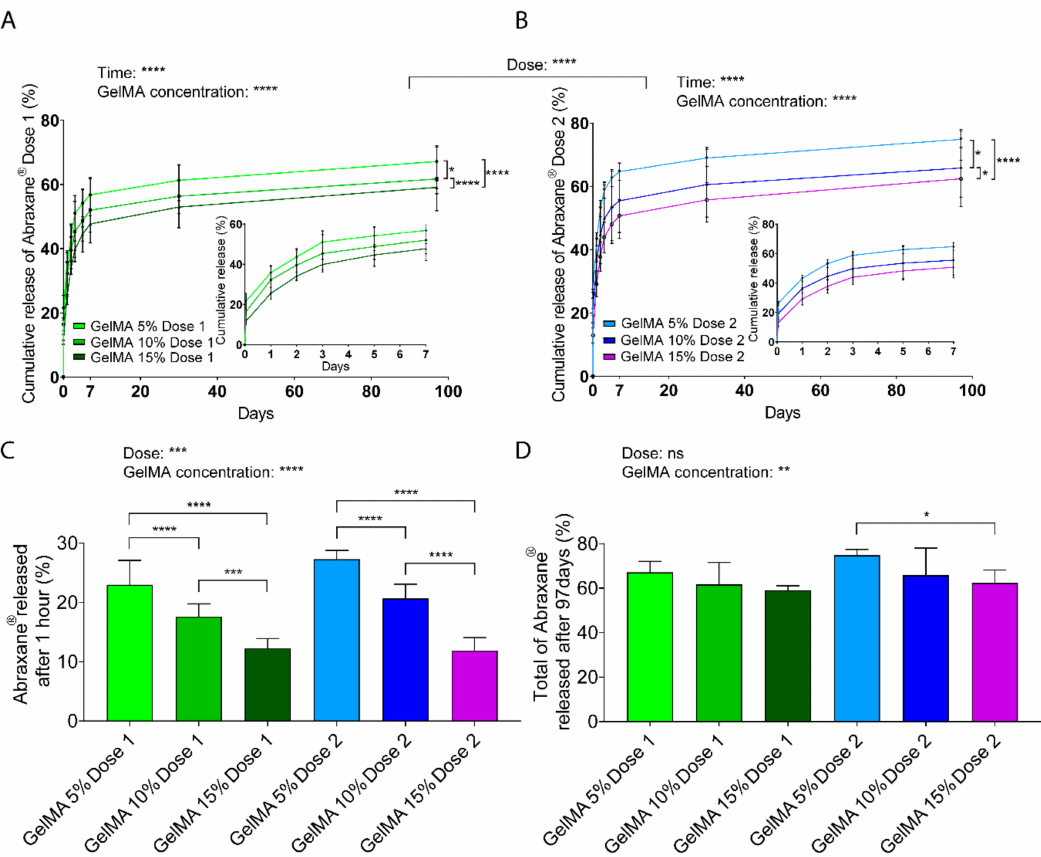
Figure 3. Release kinetics of FITC-labeled Abraxane ® from GelMA hydrogels, as measured in phosphate-bu ff ered saline pH 7.4, under gentle agitation at 37 ◦ C. ( A – B ) Cumulative release profiles, normalized to encapsulated Dose 1 (37.5 µ g) ( A ) and Dose 2 (75 µ g) (B) from 5%, 10%, and 15% w / v GelMA hydrogels. Data are shown as mean ± standard deviation (SD). ( C – D ) Fraction of FITC-Abraxane ® released in the first hour ( C ), and released after 97 days ( D ), normalized to GelMA encapsulated doses. Data are shown as mean + SD. GelMA Dose 1 and 2 refer to 37.5 µ g and 75 µ g Abraxane ® , respectively. Data are shown as mean + SD. Release experiments were repeated three times, n ≥ 5. **** p < 0.0001; *** p < 0.001; ** p < 0.01; * p <